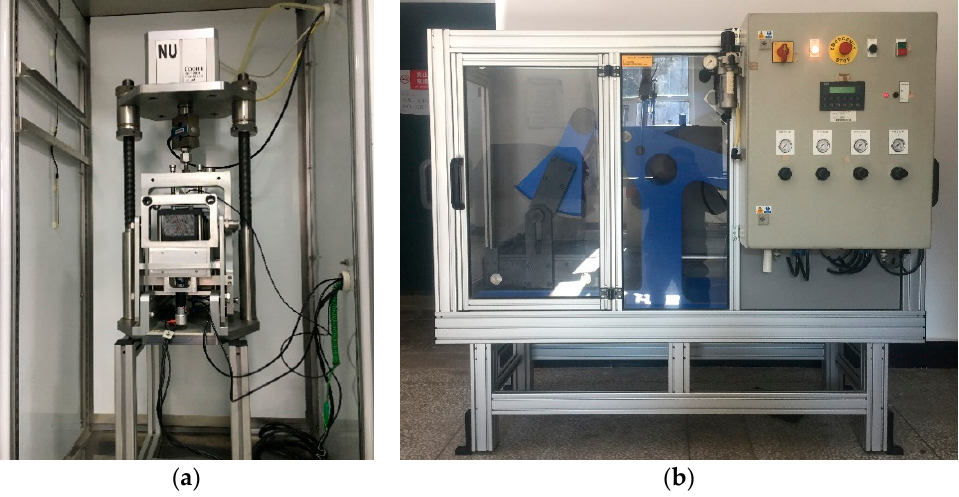
Figure 6. Equipment of Fatigue test. ( a) Fatigue testing machine; ( b ) Vibration rolling compactor.